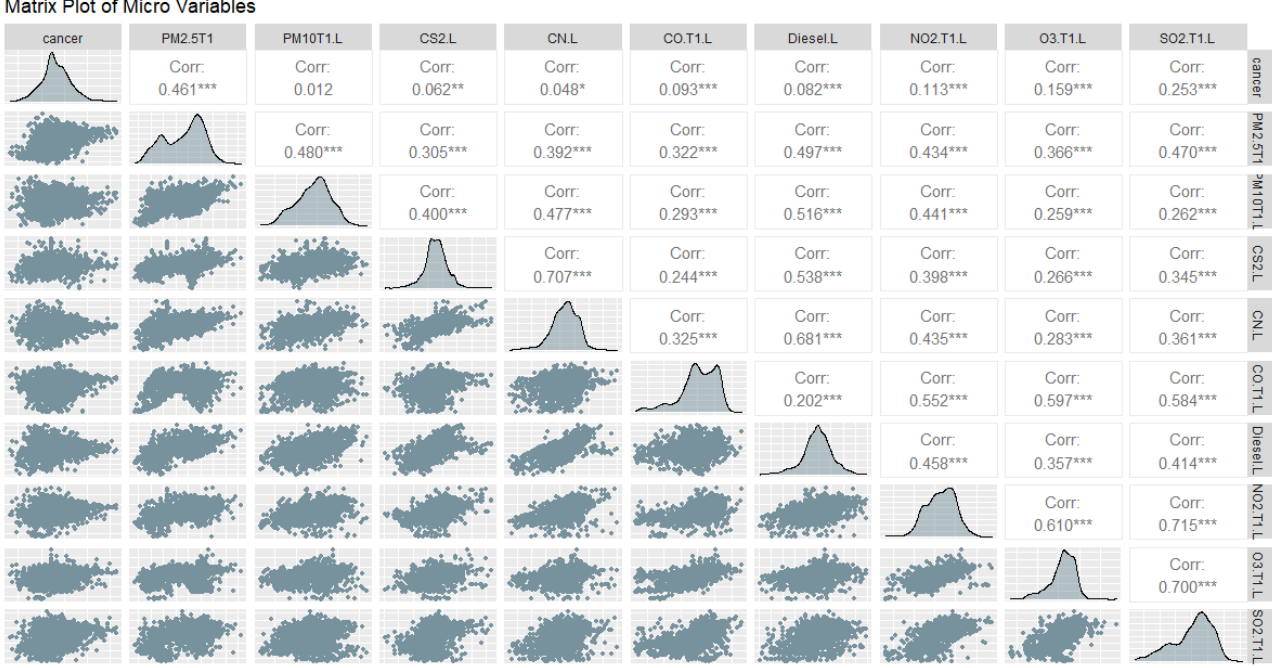
Figure 4. Matrix Plot of Lung Cancer with Variables in Time 1: Particulate Matter 2.5 and 10, Carbon Disulfide, Cyanide compounds, Carbon Monoxide, Diesel Exhaust, Nitrogen Dioxide, Tropospheric Ozone, Sulfur Dioxide. Significance codes: